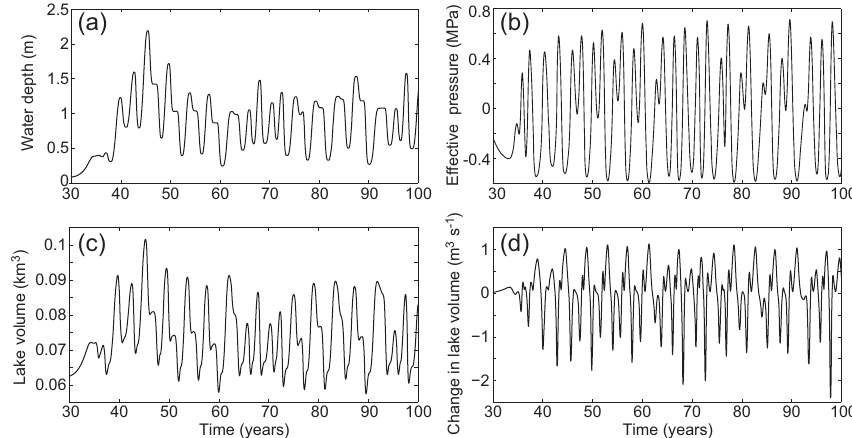
Figure 6. Conditions in the overdeepening over 100 years with (a) the maximum lake water depth, (b) the water effective pressure, (c) the volume of the lake in the overdeepening and (d) the filling (positive) and drainage (negative) rates of the lake.